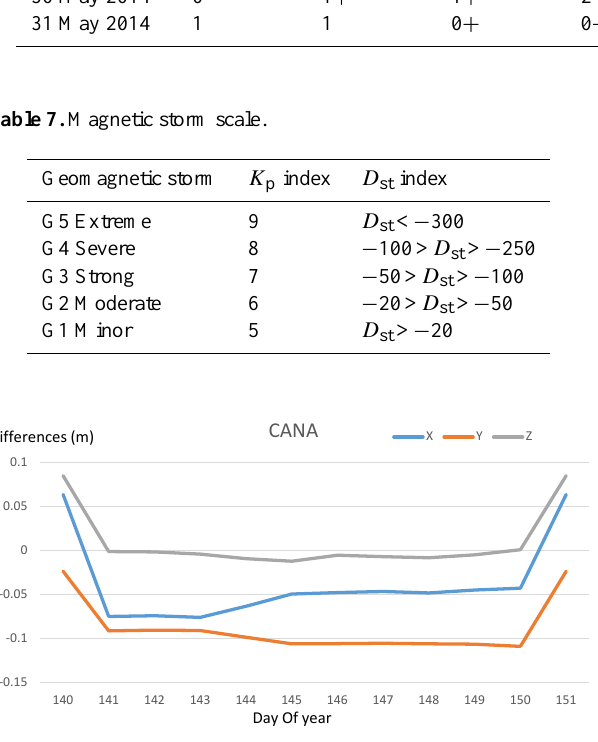
Figure 11. CANA station coordinate variations.